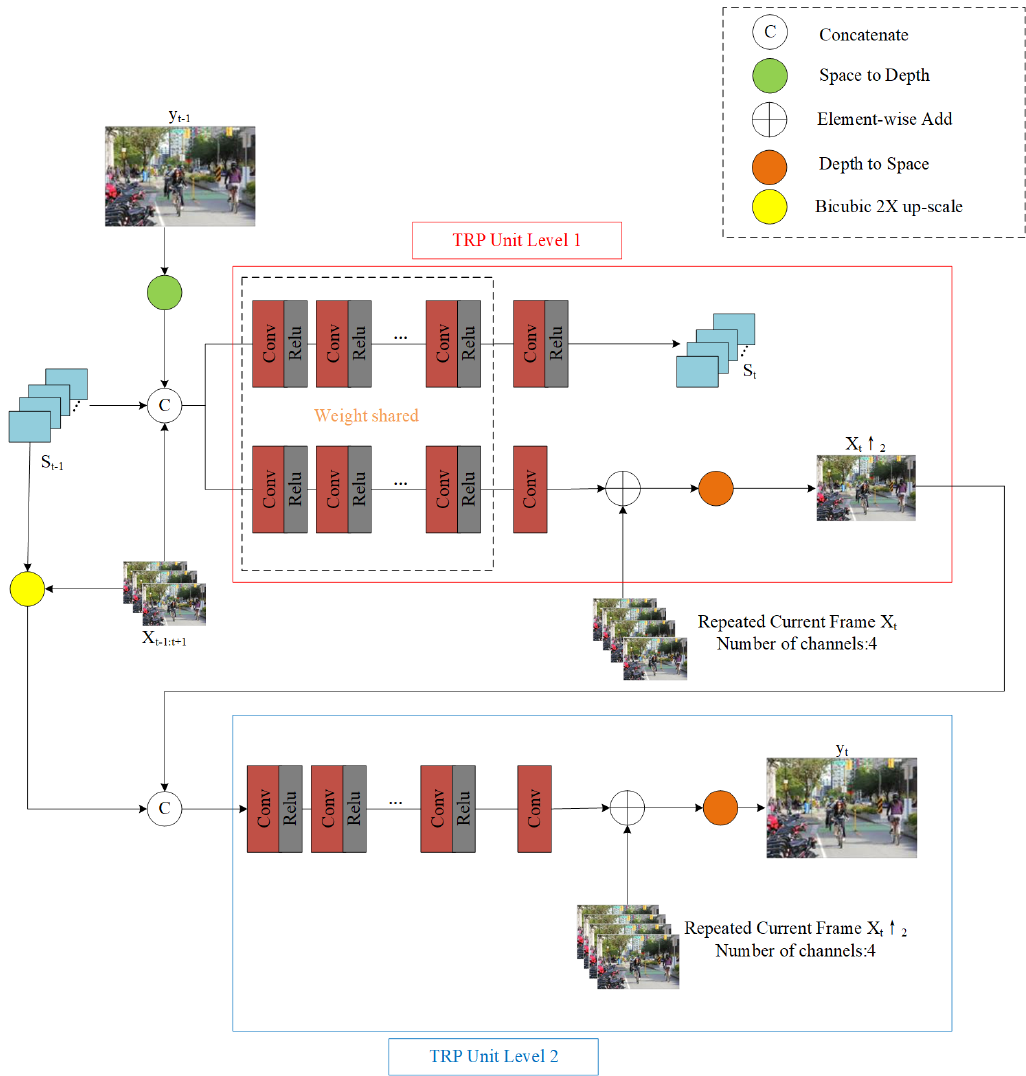
Figure 7. Progressive up-sampling TRP unit for 4 × video super-resolution